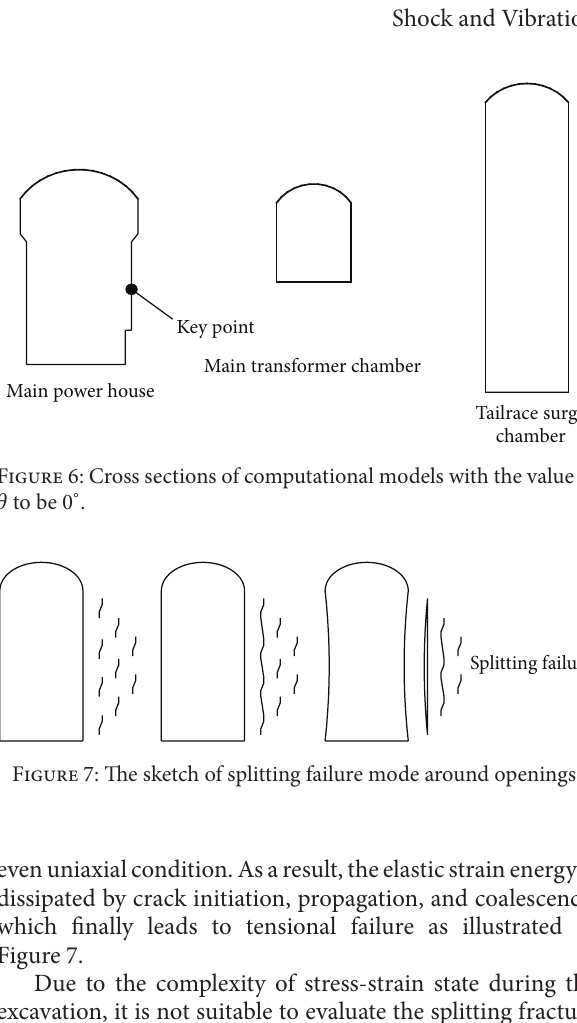
Figure 5: Cross sections of computational models with the value of 𝜃 to be 20 ∘ .